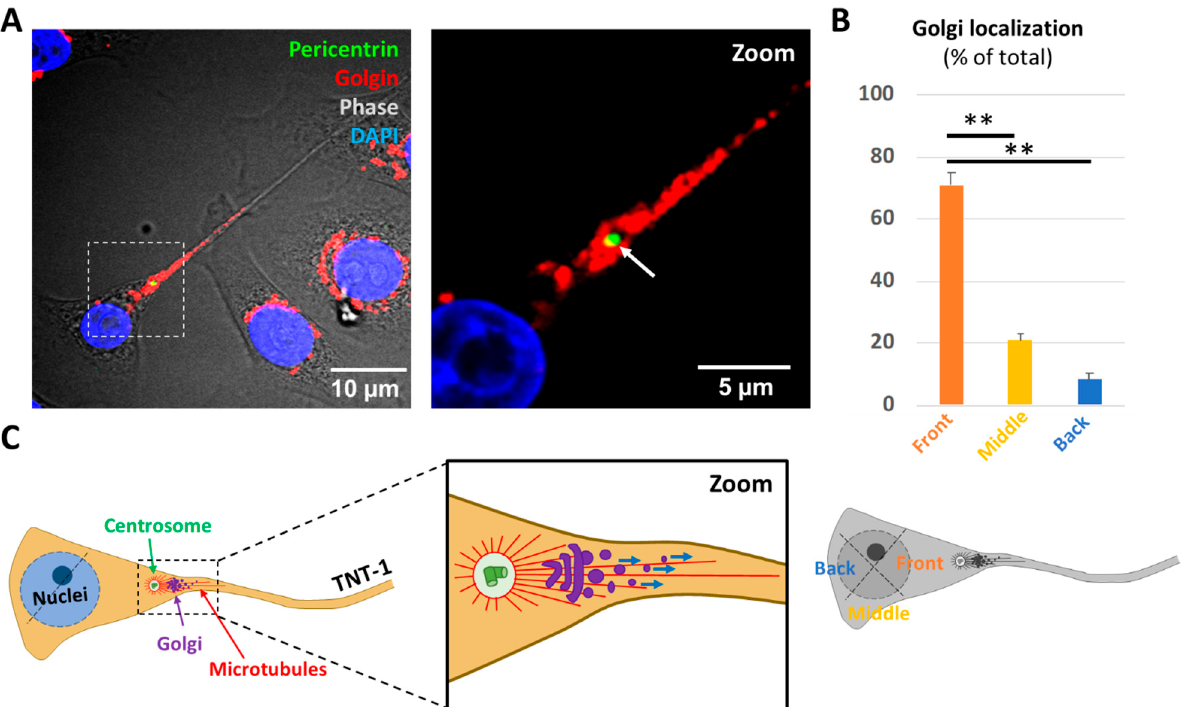
Figure 2. Pericentrosomal localization of the Golgi towards TNT’s-1 formation site facilitates intercellular trafficking. ( A ) Representative images ( B ) and quantification of pericentrosomal localization of the Golgi apparatus towards and within TNTs-1. n > 100 cells. In each TNT-formed cell, the labeled Golgi complex position was determined using a cell body centroid analysis, which divides the cell body into quadrants. The Golgi was scored as “Front” if it was positioned within a 90° sector facing the TNT-1 protrusion as illustrated. Dashed white square indicates the region used for the zoom. White arrows indicate centrosome polarization towards TNT-formed cells. ( C ) Figurative illustration of pericentrosomal localization of the Golgi apparatus and endocytic-recycling compartment towards and within TNTs-1. Boxed region used for the zoom. Arrows indicates centrosome, Golgi complex and microtubules position. Blue arrows mark bright vesicles that moved along the TNT-1. Data are represented as the mean ± SEM from at least three individual experiments. Statistical significance was calculated and p value are indicated by asterisks: ** p < 0.01.